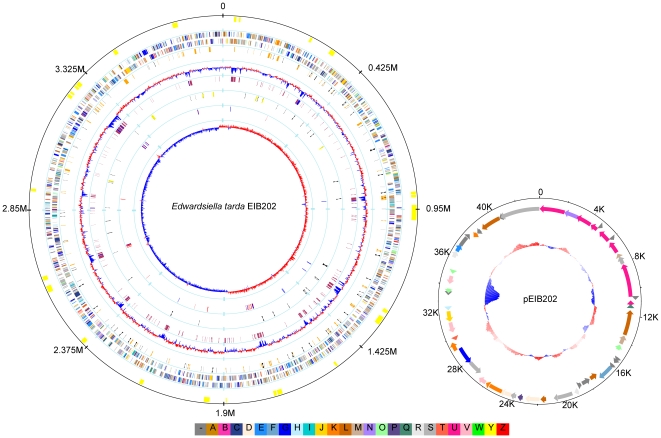
Circular atlas of E. tarda EIB202 genome and plasmid pEIB202.Left, chromosome; Right, plasmid. Circles range from 1 (outer circle) to 9 (inner circle) for chromosome and I (outer circle) to III (inner circle) for plasmid, respectively. Circle 1, genomic islands; Circles 2/I and 3/II, predicted coding sequences on the plus and minus strands, respectively; Circle 4, variable number of tandem repeats (VNTRs) (black) and direct repeat sequences (DRs) (orange); Circles 5/III, G+C percentage content: above median GC content (red), less than or equal to the median (blue); Circle 6, potential horizontally transferred genes and EIB202-specific genes with respect to Enterobacteriaceae bacteria; Circle 7, stable RNA molecules: tRNA (black), rRNA (yellow); Circle 8, phage-like genes and transposases; Circle 9, GC skew (G−C)/(G+C): values>0 (red), values<0 (blue). All genes are colored by functional categories according to COG classification: gold for translation, ribosomal structure and biogenesis; orange for RNA processing and modification; light orange for transcription; dark orange for DNA replication, recombination and repair; antique white for cell division and chromosome partitioning; pink for defense mechanisms; tomato for signal transduction mechanisms; peach for cell envelope biogenesis and outer membrane; deep pink for intracellular trafficking, secretion and vesicular transport; pale green for posttranslational modification, protein turnover and chaperones; royal blue energy production and conversion; blue for carbohydrate transport and metabolism; dodger blue for amino acid transport and metabolism; sky blue for nucleotide transport and metabolism; light blue for coenzyme metabolism; cyan for lipid metabolism; medium purple for inorganic ion transport and metabolism; aquamarine for secondary metabolites biosynthesis, transport and catabolism; gray for function unknown.